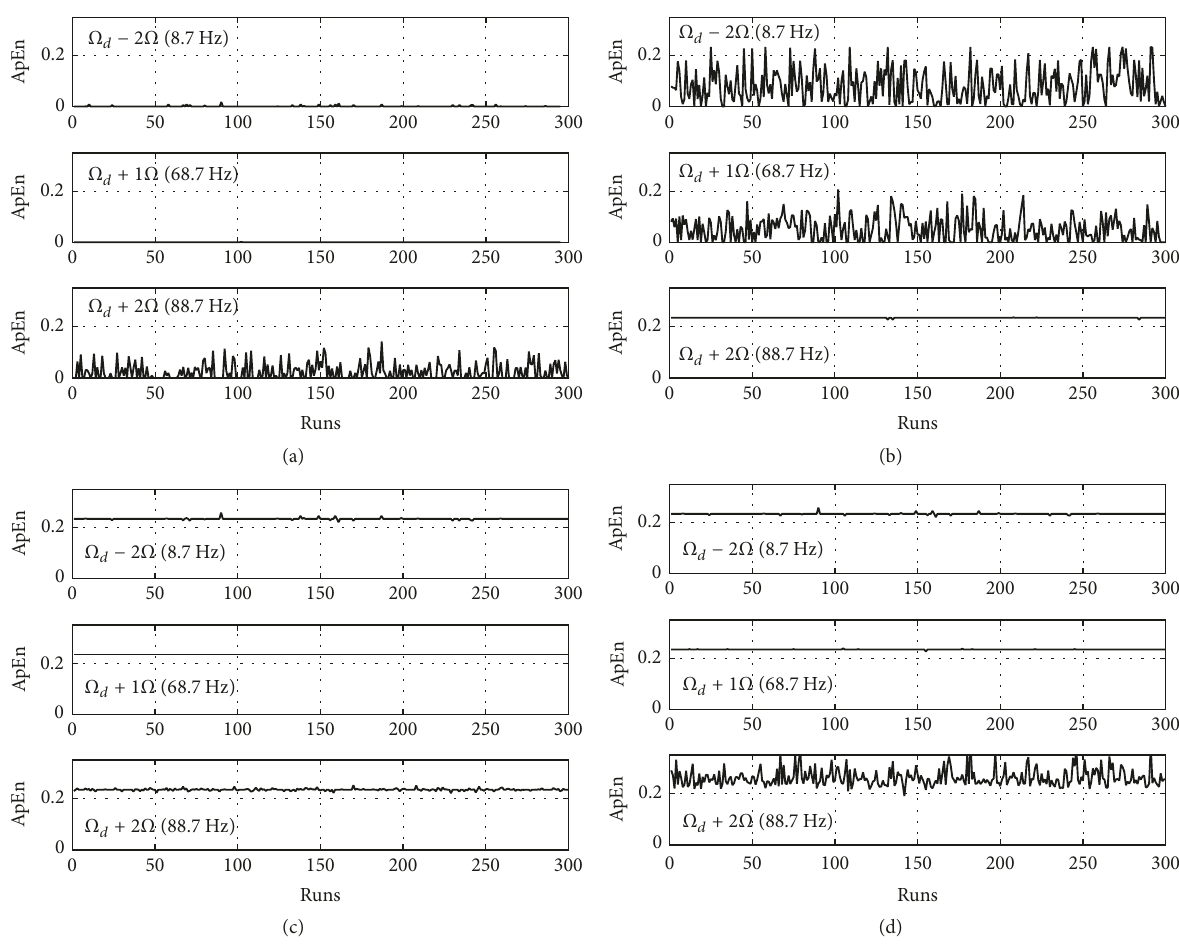
Figure 13: Approximated Entropy value of the combination resonances at 8.7 Hz, 68.7 Hz, and 88.7 Hz (SNR = 1000, 𝑟 = 5 × 10 −5 ): (a) 1% crack depth; (b) 3% crack depth; (c) 5% crack depth; (d) 10% crack depth.